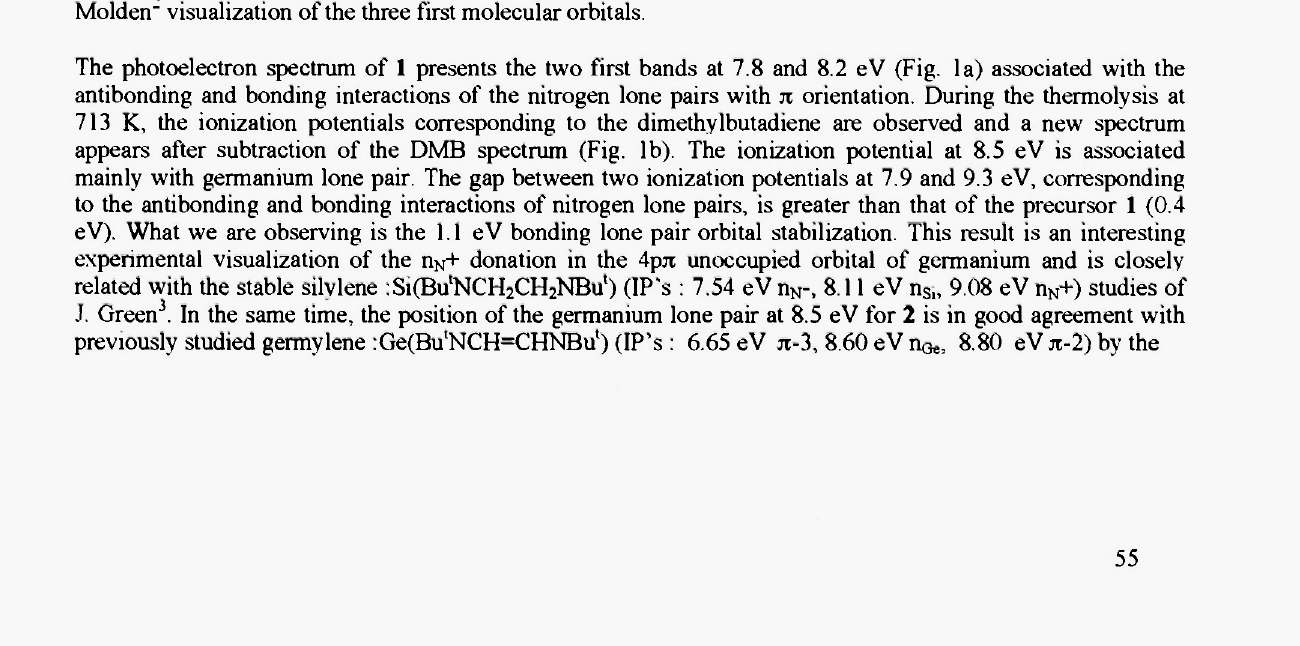
Figure 1 Photoelectron spectrum of! a) 1, b) 1 at 713K after subtraction of the DMB spectrum of and Molden" visualization of the three first molecular